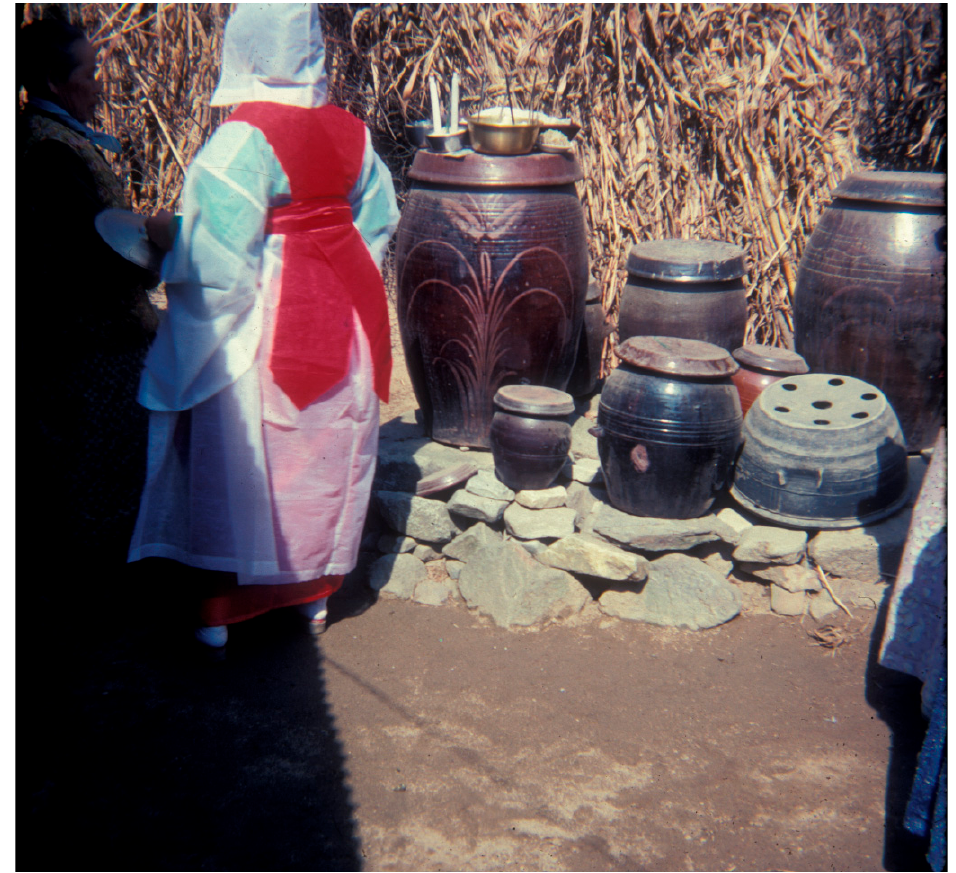
Figure 3. The jars are in domestic use, filled with condiments, but because the storage platform is a clean, high place, the tall jar here becomes a temporary platform for offerings to the Mountain God and the Seven Stars, 1977. Photograph by author.